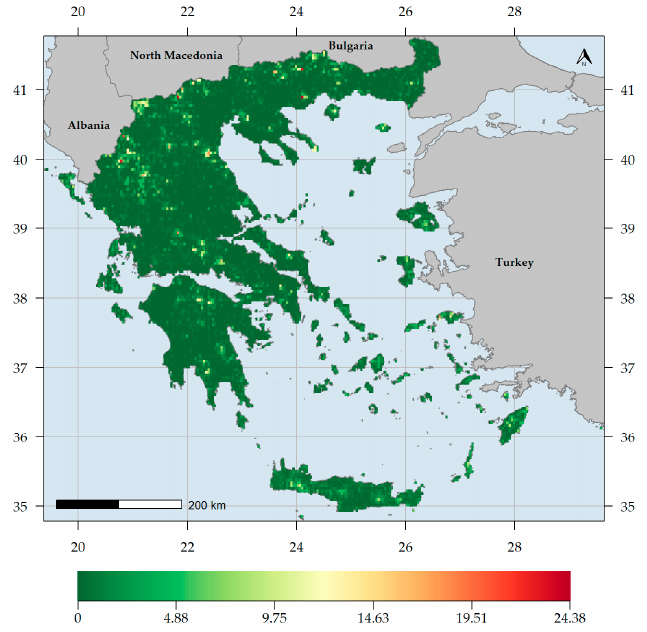
Figure 6. Corrected weighted endemism values for the native plant taxa (CWE NAT ) occurring in each grid cell in Greece.